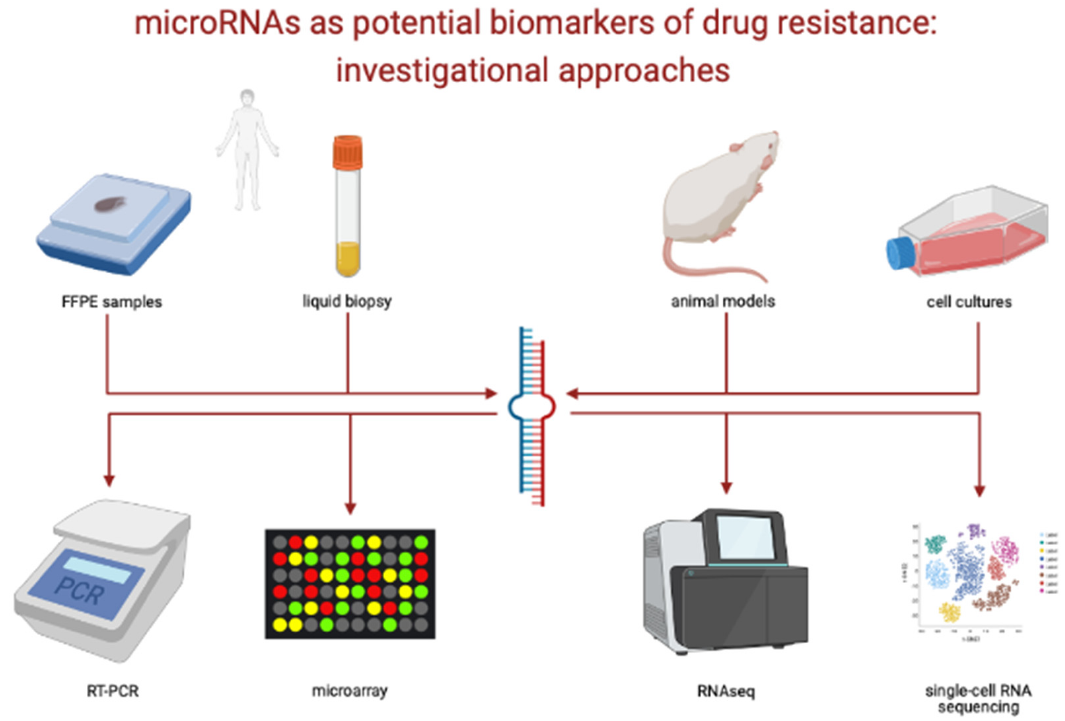
Figure 2. Investigational approaches of miRNAs as potential predictive biomarkers. Credits to BioRender.com.